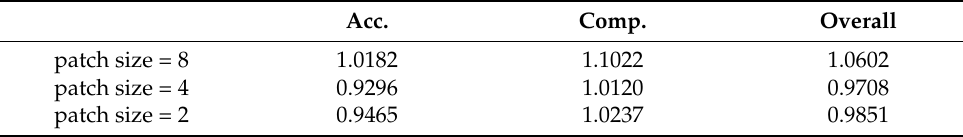
Table 3. Ablation study on the size of patch on DTU